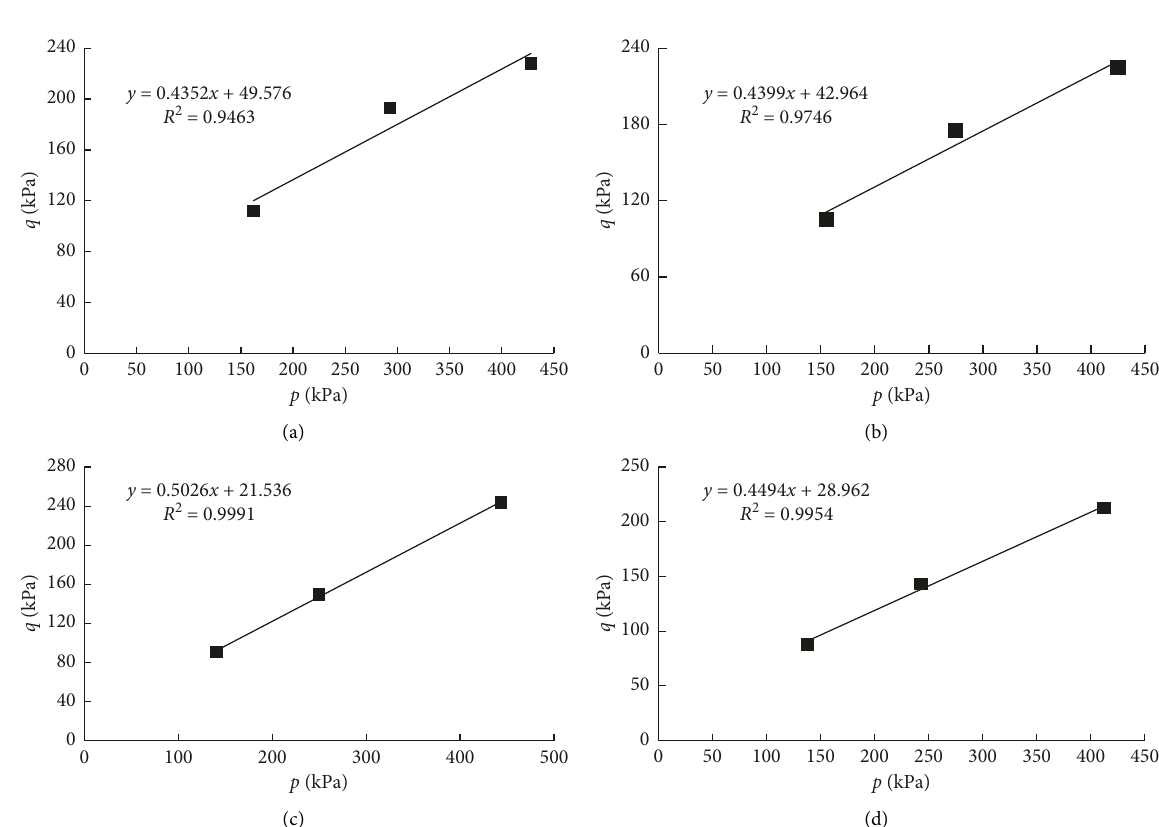
Figure 2: p-q relation curves of acid-contaminated clay with different concentrations. (a) Uncontaminated soil. (b) 1% HCL. (c) 3% HCL. (d) 5%